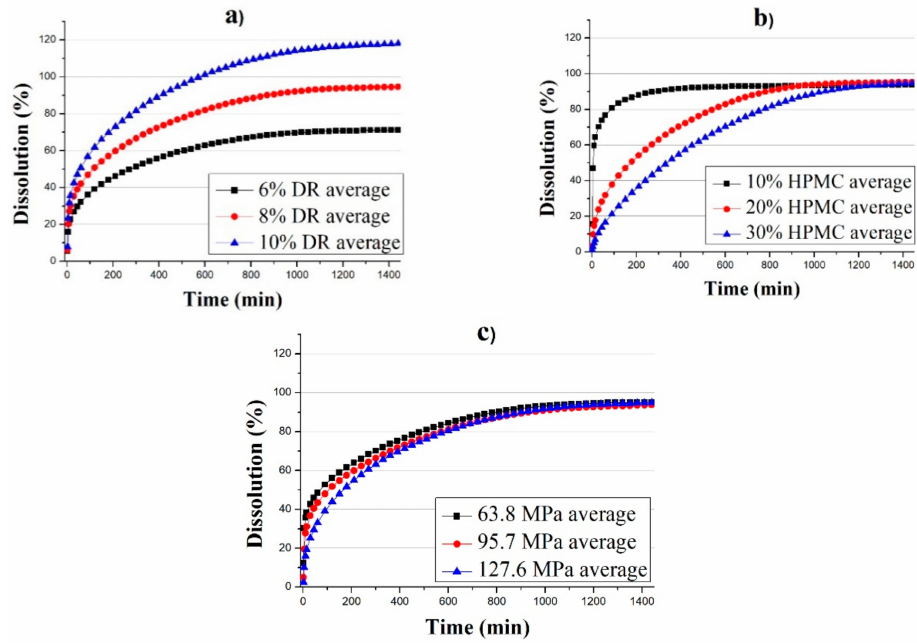
Figure1. Averagedissolutionprofilessortedby( a )DRcontent; ( b )HPMCcontent; ( c